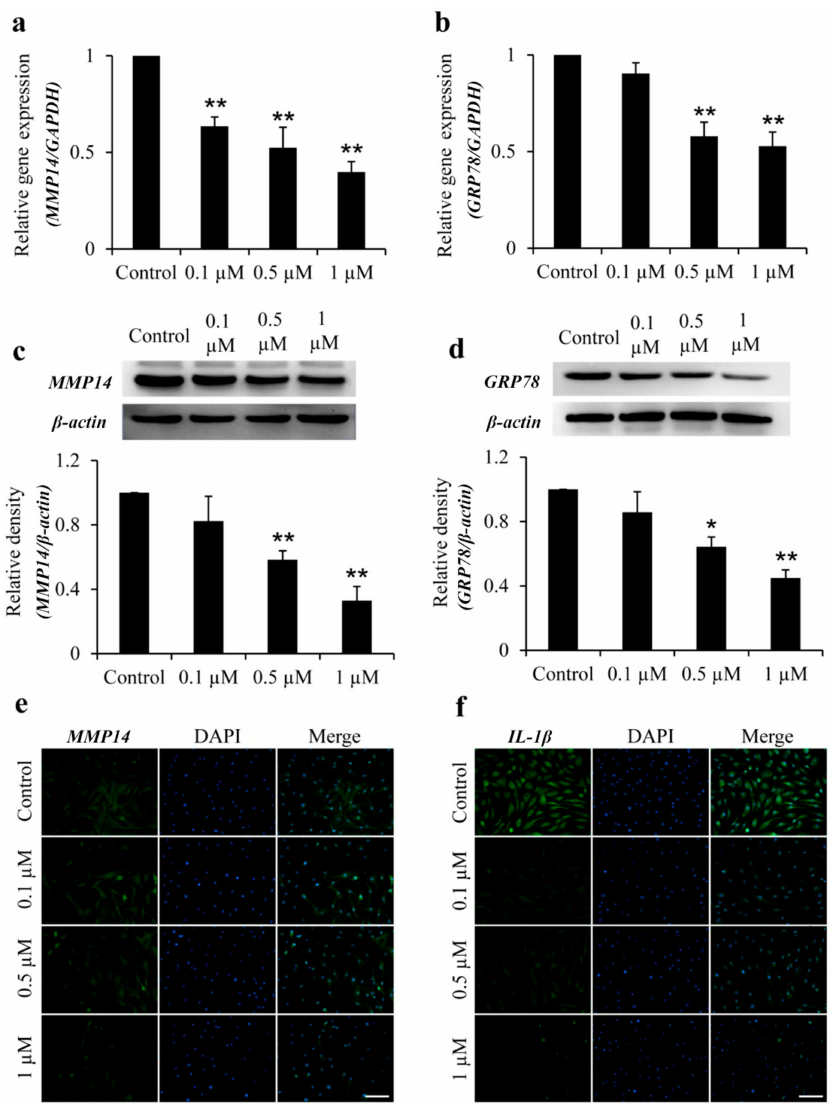
Figure 4. Effects of icariin on MMP14 , GRP78 , and IL-1 β expression in OA–FLSs. ( a , b ): The mRNA expression level of MMP14 ( a ) and GRP78 ( b ) of OA–FLSs with different concentrations of icariin treatment for 12 h. ( c , d ): The protein synthesis of MMP14 ( c ) and GRP78 ( d ) of OA–FLSs with different concentrations of icariin treatment for 12 h. Statistical difference when compared to the control (* p < 0.05), significant difference when compared to the control (** p < 0.01) (mean ± SD, n = 3). ( e , f ) Immunofluorescence of the MMP14 ( e ) and IL-1 β ( f ) of OA–FLSs with different concentrations of icariin treatment for 12 h. Scale bar: 100 µ